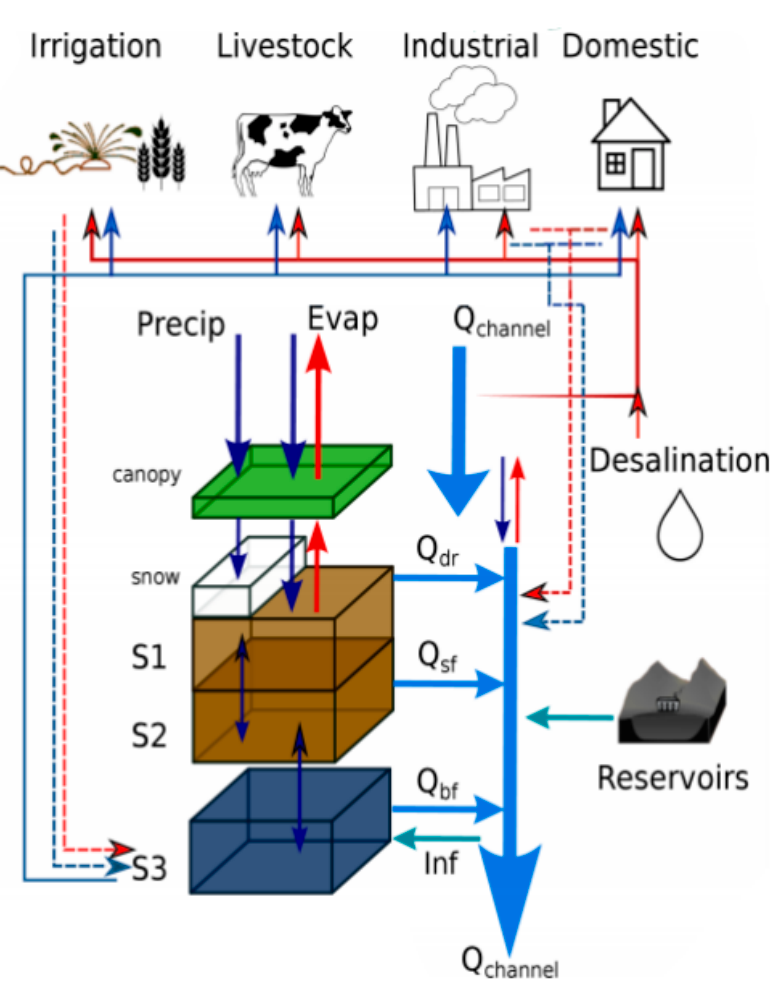
Figure 1. Schematic overview of a PCR-GLOBWB cell and its modelled states and fluxes. S1, S2 (soil moisture storage), S3 (groundwater storage), Qdr (surface runoff—from rainfall and snowmelt), Qsf (interflow or stormflow), Qbf (baseflow or groundwater discharge), Inf (riverbed infiltration). The thin red lines indicate surface water withdrawal, the thin blue lines groundwater abstraction, the thin red dashed lines return flows from surface water use and the thin dashed blue lines return flows from groundwater use surface. For each sector applies: withdrawal—return flow = consumption. Water consumption adds to total evaporation. Source: Sutanudjaja et al., (2018) [14].